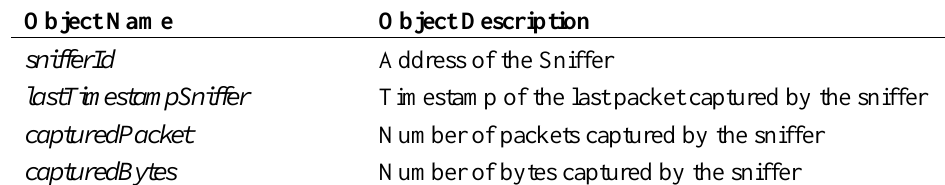
Table 3. Objects represented in the snifferTable